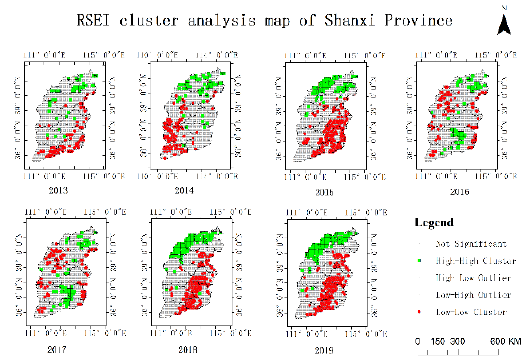
Figure 5. Geodetector results of Shanxi for 2013-2019